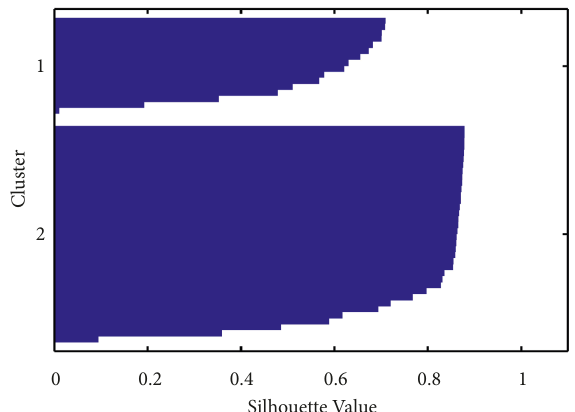
Figure 5: Silhouette value of the scroll wheel damage character- istics divided into two clusters.